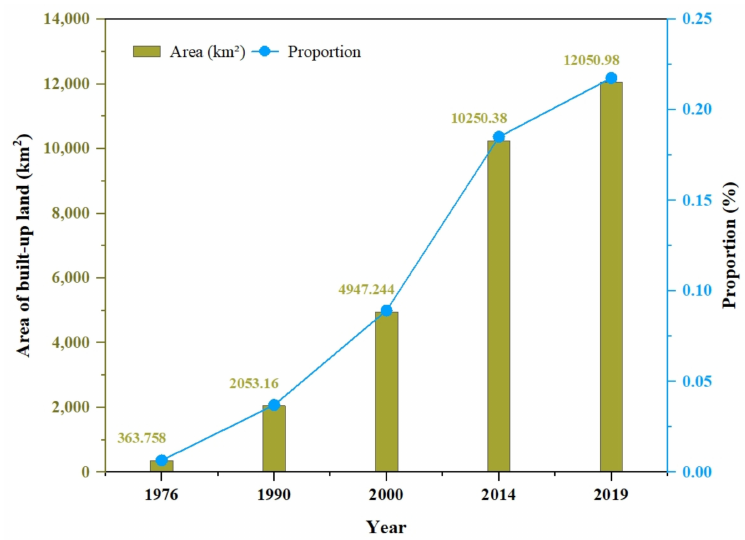
Figure 6. Area of built-up land and proportion of study area from 1976 to 2019.